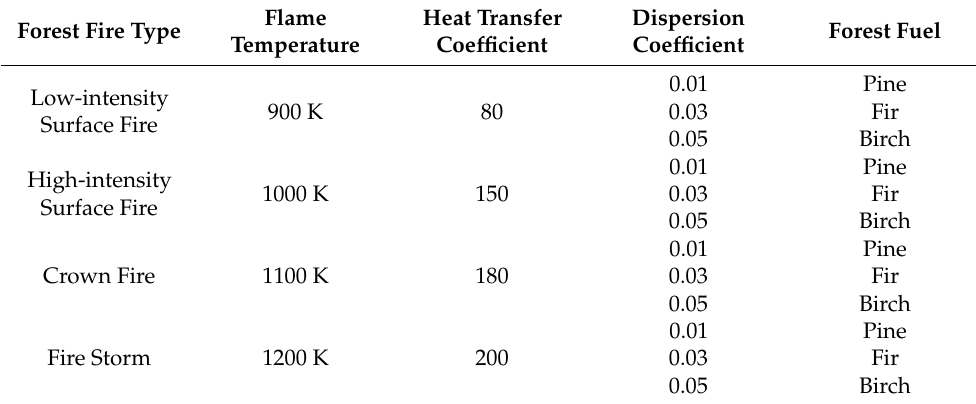
Table 1. Main scenario on heat transfer modeling of firebrand with soot formation. Forest Fire